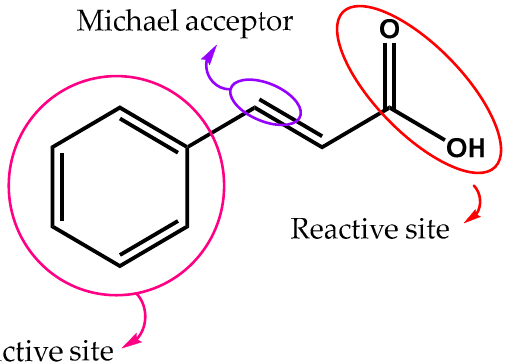
Figure 1. Reactive sites in the CA structure.